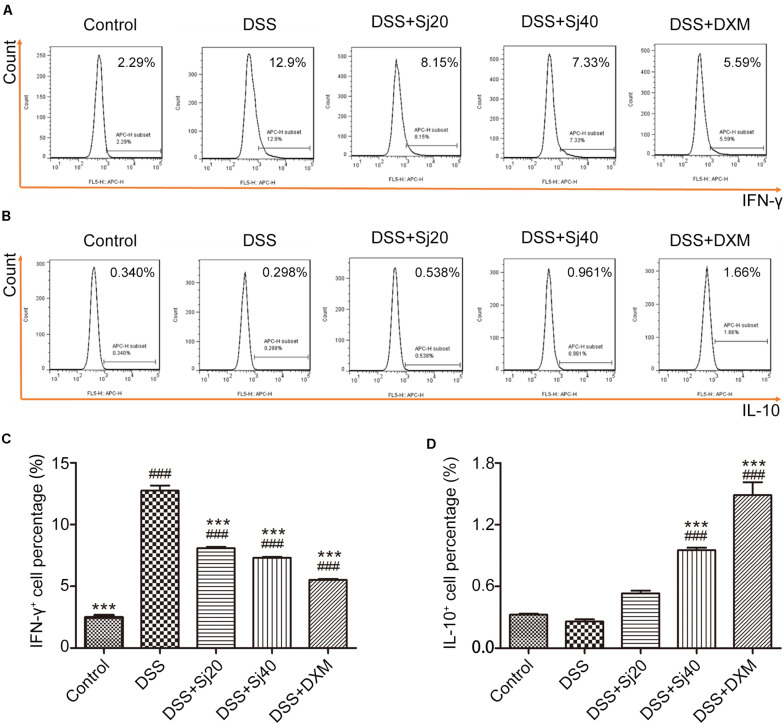
Mice treated with mSjci display decreased production of the proinflammatory cytokine IFN-γ and enhanced expression of the anti-inflammatory cytokine IL-10. (A) At the termination of the animal experiment, the spleen of each mouse was eviscerated and then analyzed by flow cytometry to test the production of IFN-γ. (B) Similarly, the expression of IL-10 was determined by flow cytometry to analyze the percentage of IL-10+ cells. (C,D) Quantification of the cells positive for IFN-γ (C) or IL-10 (D) in each group. The data (means ± SDs; n = 5) were analyzed by one-way ANOVA. ###p < 0.001 compared with the control group; ***p < 0.001 compared with the DSS group.